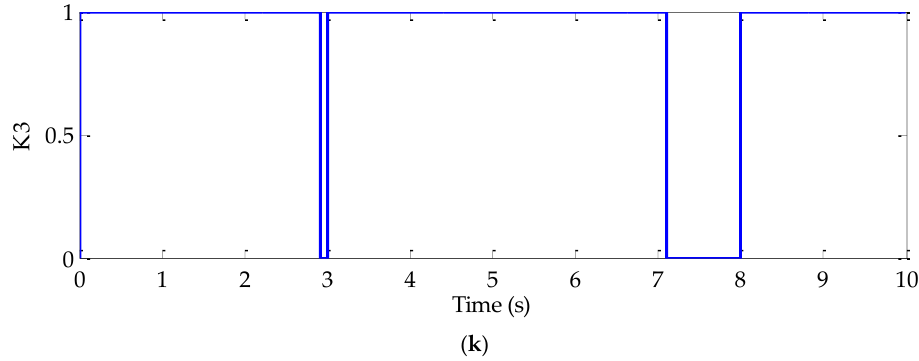
Figure 12. Simulation results under variable target vehicle speed: ( a ) temperature and radiation trajectories, ( b ) vehicle speeds, ( c ) PV generator power, ( d ) load torque, ( e ) DC − link voltage, ( f ) vehicle consumed power, ( g ) battery state of charge, ( h ) battery state of charge operating mode, ( i ) switch K1, ( j ) switch K2, and ( k ) switch K3.